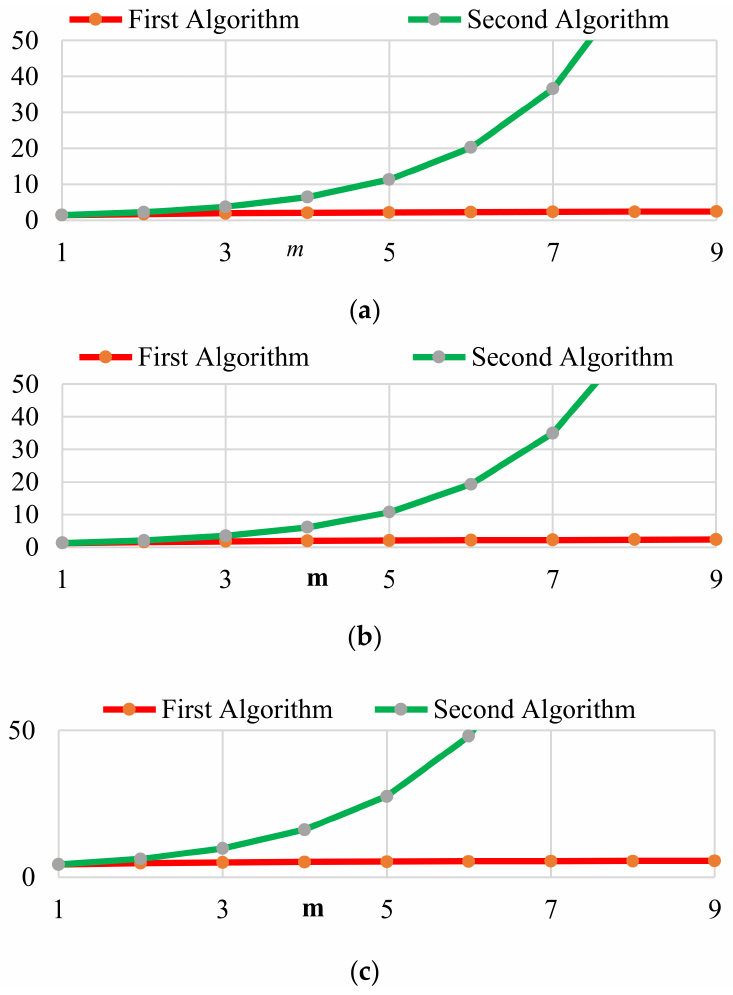
Figure 6. Optimization of structures for maximizing the number of levels for constant ( a ) number of switches ( b ) number of drivers and ( c ) number of dc